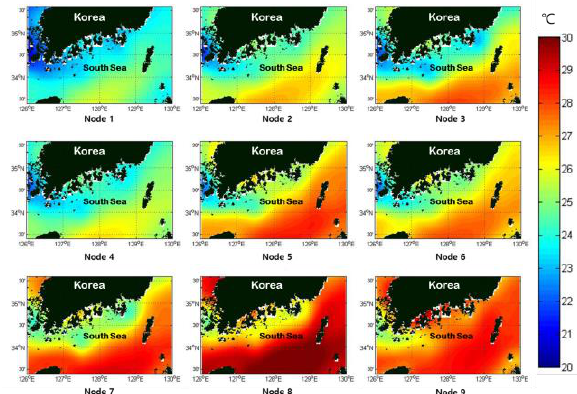
Figure 1. Spatial distribution of SST images when by using SOM algorithm when red tide occurred from 2013 to 2018.